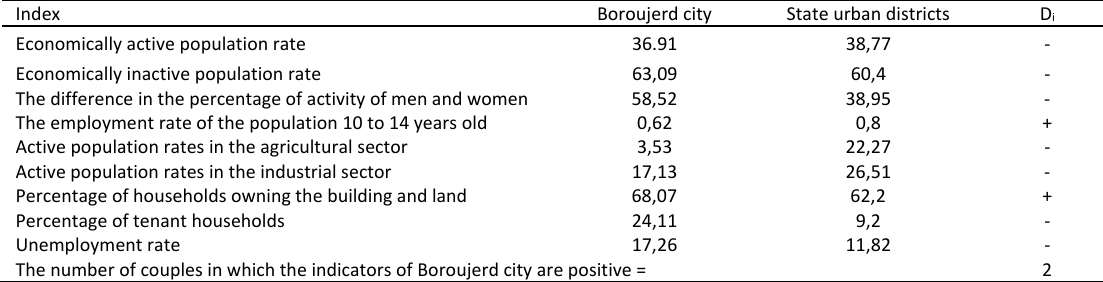
Table2: Comparison of selected economic indicators of Boroujerd city and urban districts of Iran Index